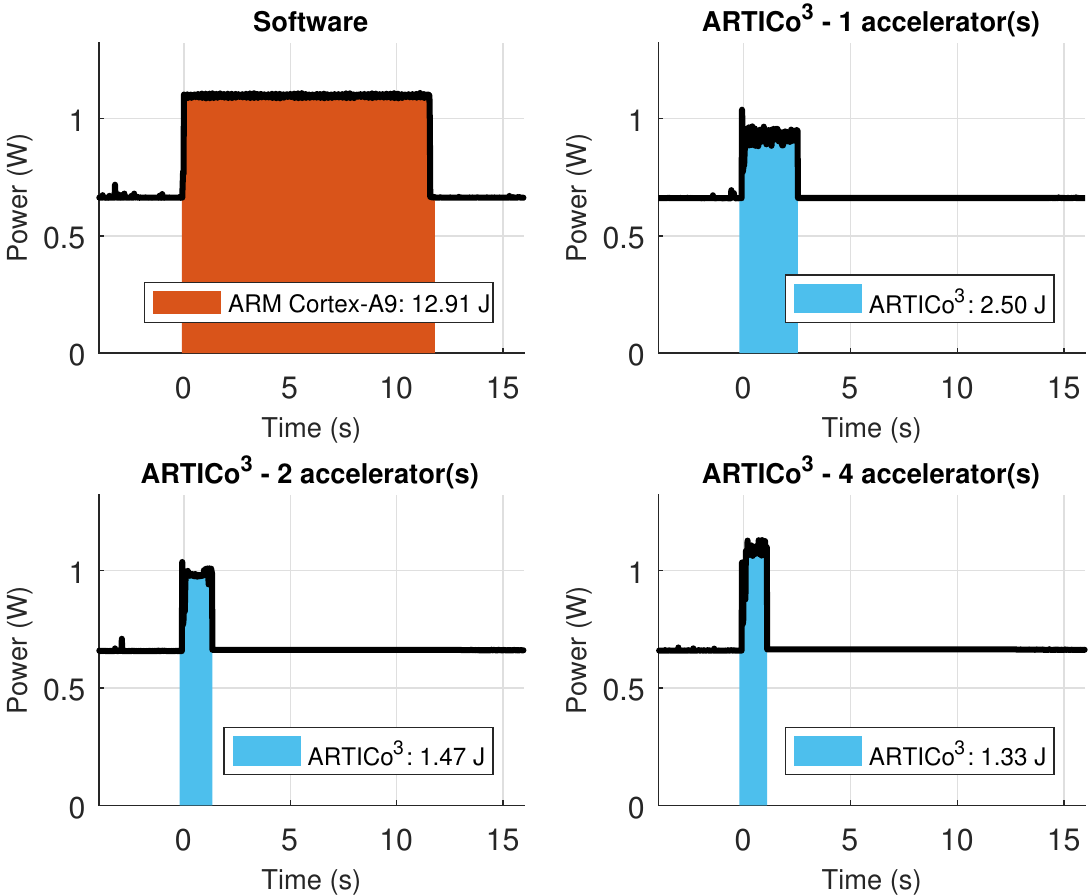
Figure 17. Energy consumption in the Zynq-based board during both software- and ARTICo 3 -based processing when changing the number of accelerators.